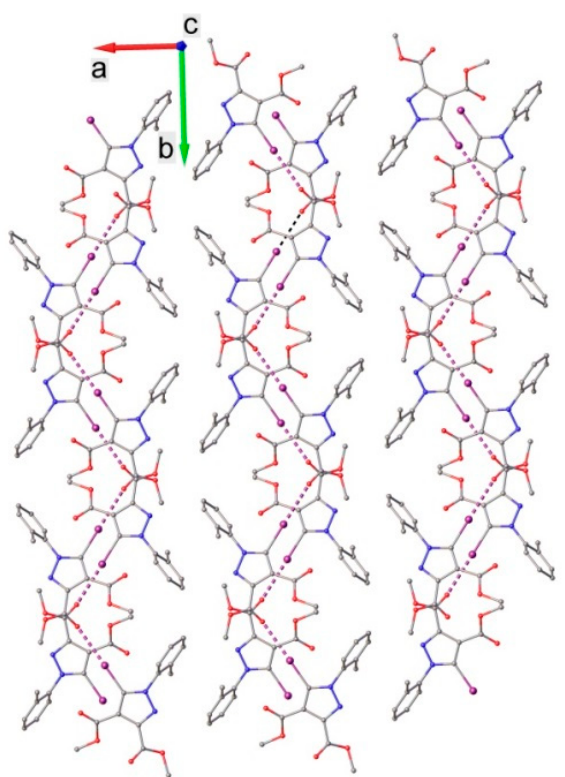
Figure 5. Crystal packing diagram of 1 viewed along the c- axis. H atoms are not shown.